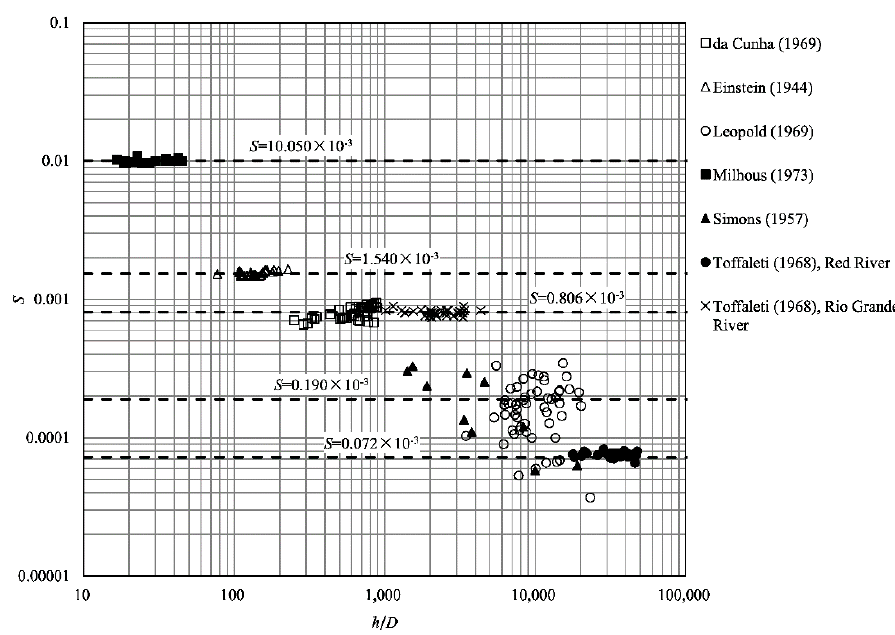
Figure 7. The relation of the bed slope S to the relative depth h / D .